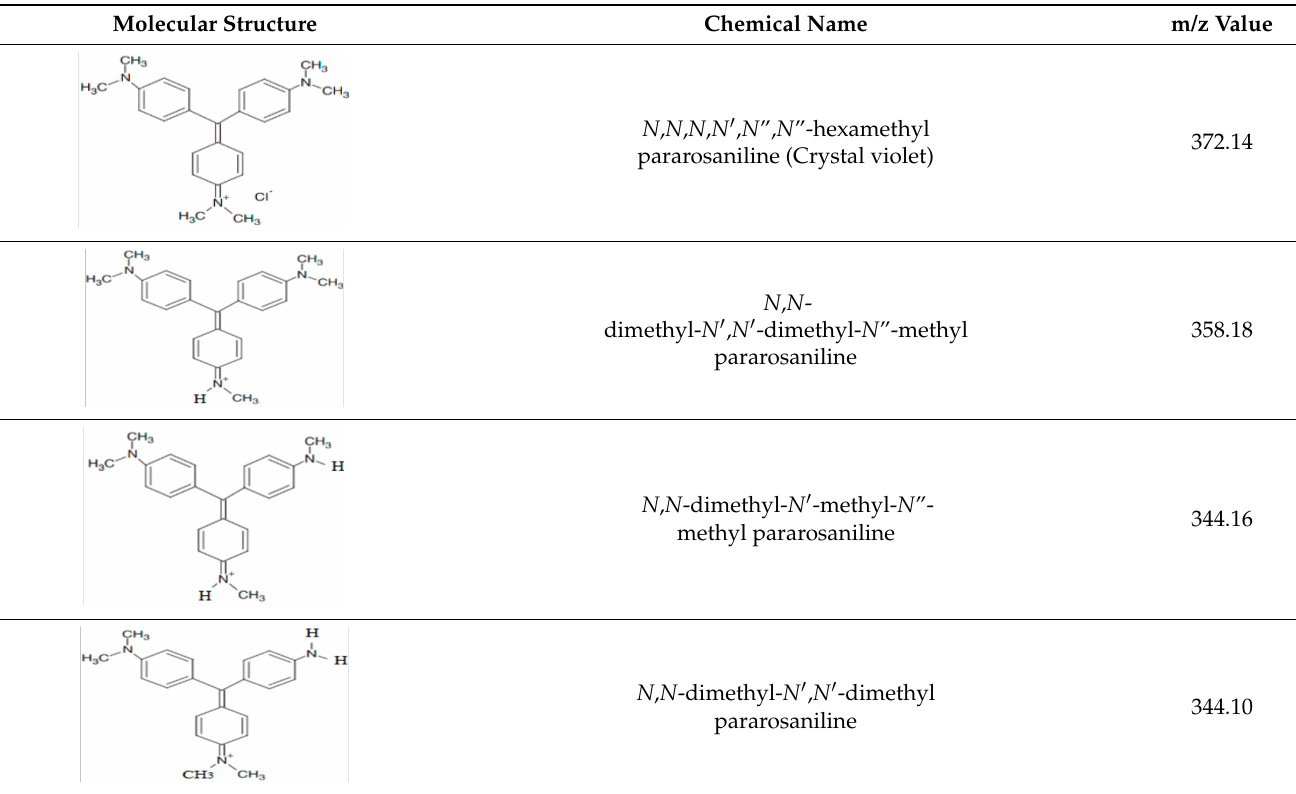
Table 4. Molecular structure, chemical names, and m/z values of demethylated intermediates of CV dye detected by